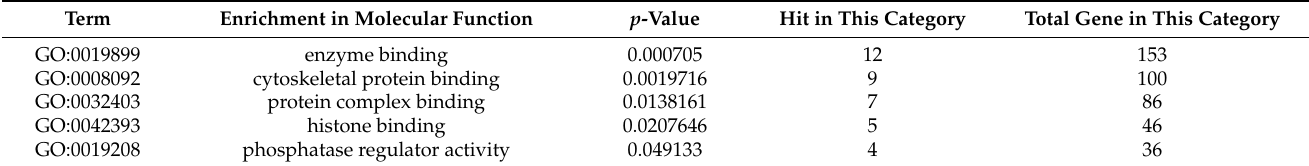
Table 3. Enrichment categories in GO molecular functions for the protein targets of